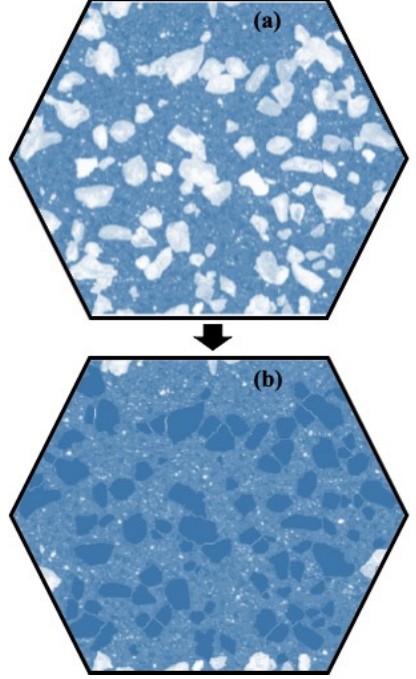
Figure 16. Effect of thresholding: ( a ) before thresholding; ( b ) after thresholding (modified from [142]).